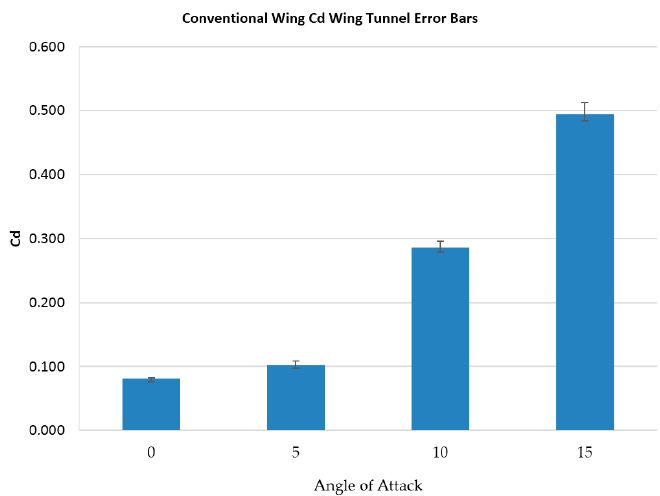
Figure 8. Conventional wing drag coefficient wind tunnel error bars.